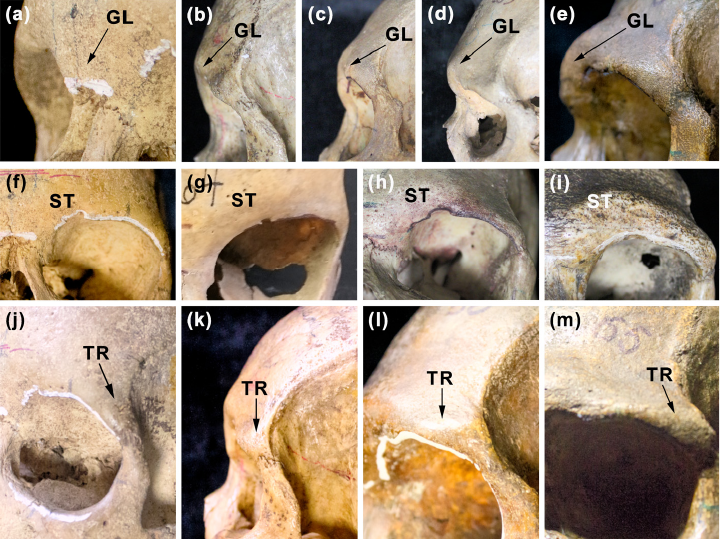
Figure 2. The supraorbital regions of the facial skeleton assessed in the examined human skulls in terms of their degree of massiveness expression: GL—glabella (( a ) grade 1, flat area or minimal projection; ( b ) grade 2, slight prominence; ( c ) grade 3, moderate prominence; ( d ) grade 4, marked prominence; and ( e ) grade 5, the strongest, convex area and very well pronounced—loaf-shaped), ST—superciliary ridge (( f ) grade 1, flat area or minimally projecting; ( g ) grade 2, clearly identifiable distinct unit; ( h ) grade 3, well pronounced; and ( i ) grade 4, anteriorly prominent area and very well pronounced), and TR—trigone (( j ) grade 1, the area with a smooth or minimally salient surface; ( k ) grade 2, the area is raised in this region and extended anteriorly; ( l ) grade 3, the area is rounded, widened and prominent; and ( m ) grade 4, the area well developed and rounded with a rugged or non-rugged surface).